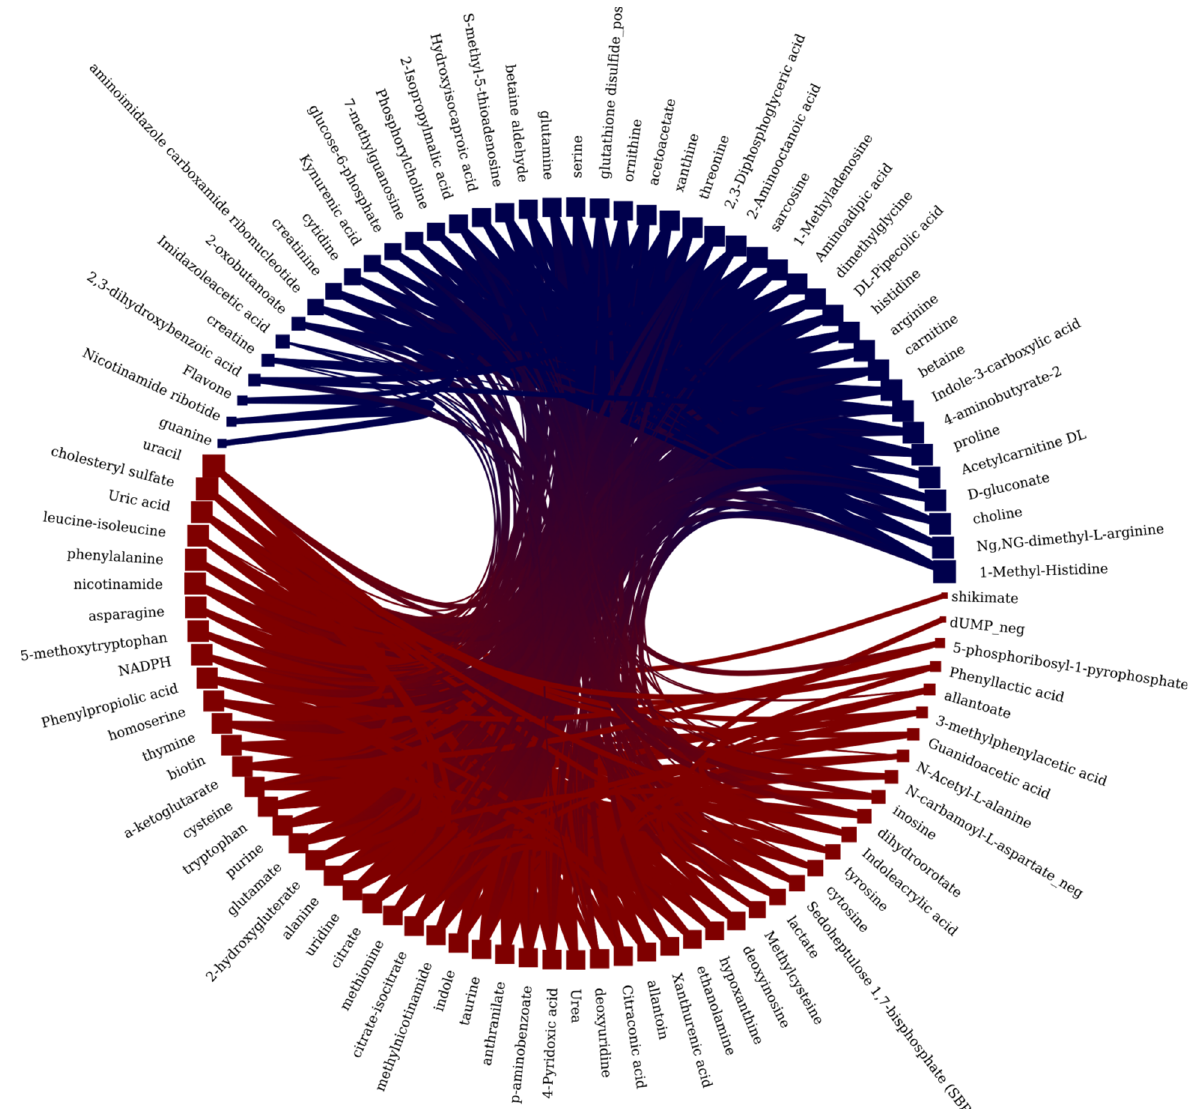
Figure 5. Graph of pairwise robust correlations between the metabolites in CSF or plasma samples. Vertices correspond to metabolites and edges to correlations. Red and blue vertices’ color corresponds to the first and second block inferred from the main graph.